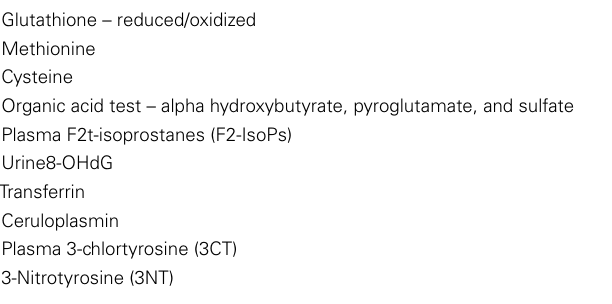
Table 2 | Oxidative stress biomarkers inASD (see text for references) .